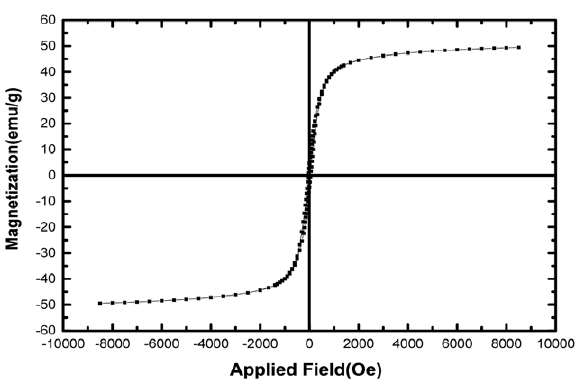
Table 1. Optimization of the reaction conditions.